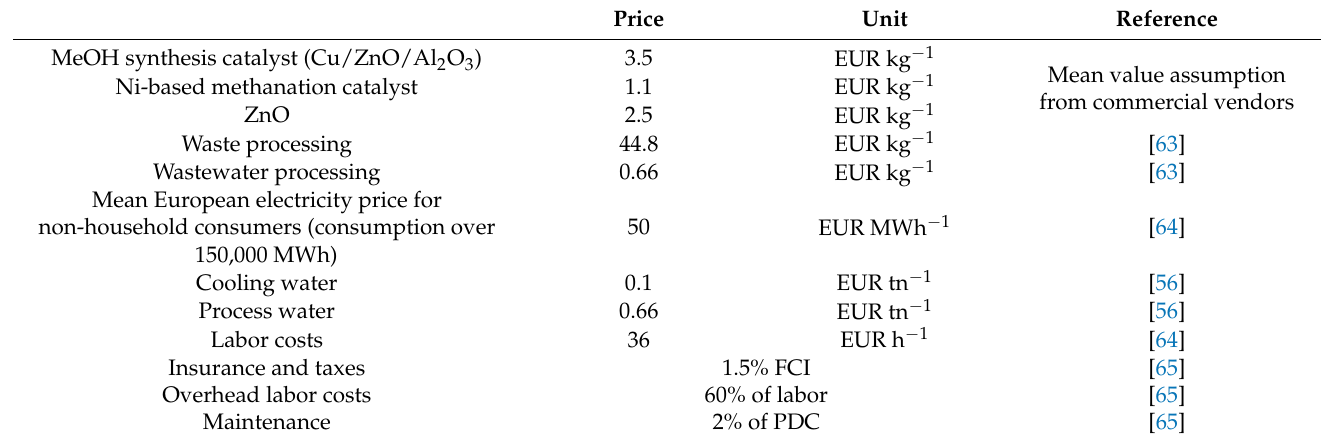
Table 7. Operational expenses for the base-case conditions.